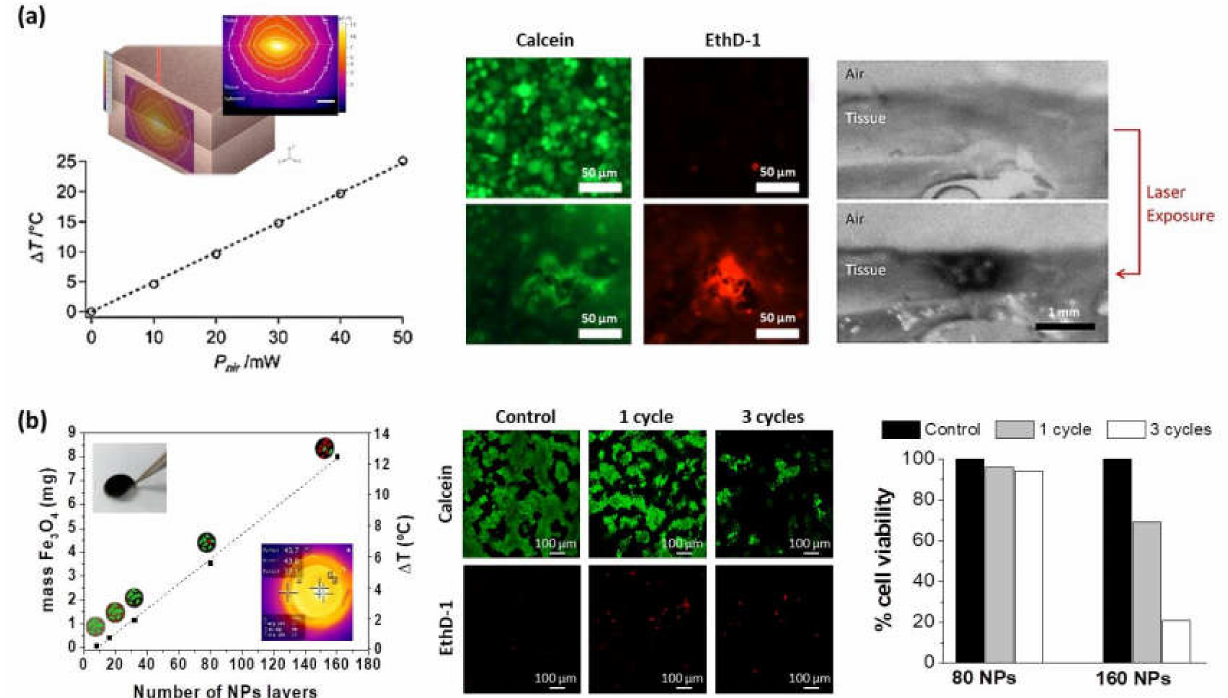
Figure 9. ( a ) Maximum temperature increase dependence on nominal laser power for a thermofilm TNF10x with the inset showing the TNF-mediated thermalization of chicken breast tissue upon laser irradiation. Cell viability assay: calcein and EthD-1, signal before and after laser exposure ( λ = 785 nm, 50 mW, 150 s) of TNF10x in contact with human neuroblastoma cells (Adapted and reprinted with permission from [131]; Copyright 2014 American Chemical Society); ( b ) Determination of Fe 3 O 4 content and temperature increase as a function of the number of NP layers deposited in the presence of an alternating magnetic field (AMF) (left). (ALG/CHI) 40 (NPs/CHI) 160 films subjected to 0 cycles of MHT (control), 1 cycle of MHT (30 min), and 3 cycles of MHT (30 min, 5 h waiting time between cycles). Note that cells are labeled with calcein (live cells in green) and EthD-1 (dead cells in red). Determination of % cell viability obtained from the images corresponding to live cells stained in green (Adapted and reprinted with permission from [132]. Copyright 2017 The Royal Society of